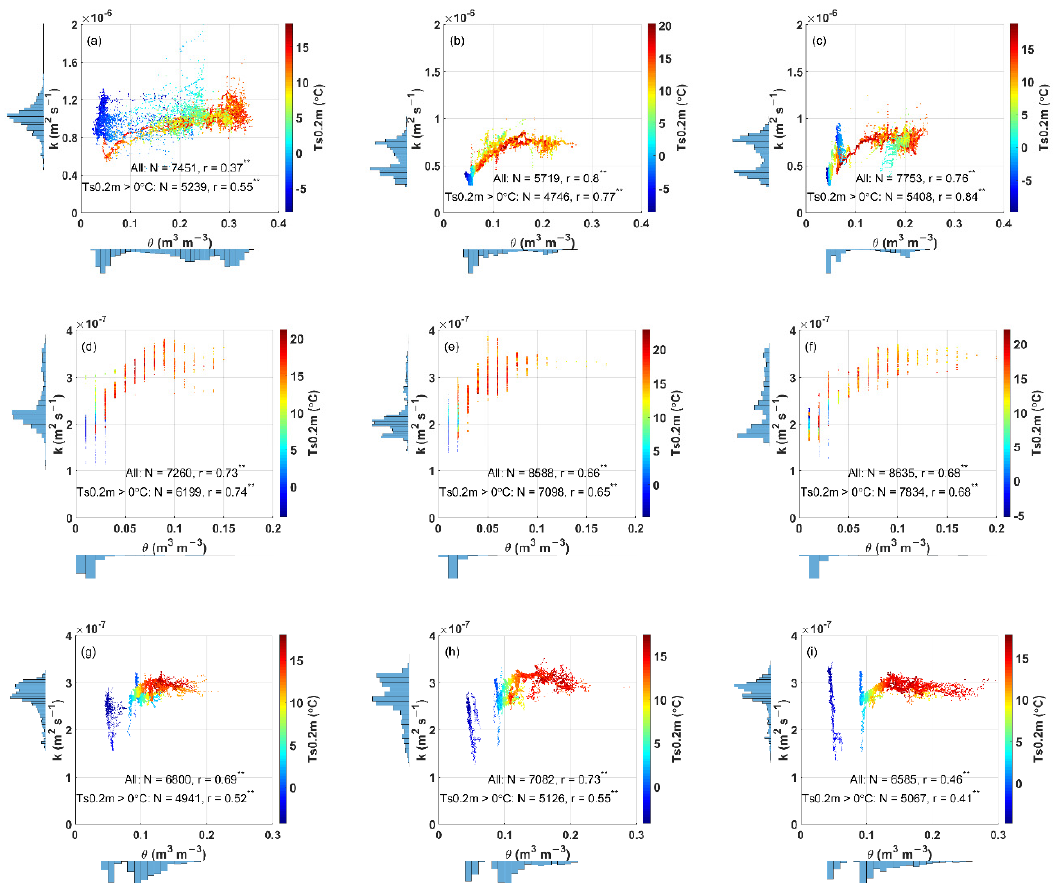
Figure 6. The variation of soil apparent thermal diffusivity (k, m 2 s − 1 ) with soil moisture ( θ , m 3 m − 3 ) at 0.10 m depth on an hourly timescale for 2014 (in the 1st column), 2015 (in the 2nd column) and 2016 (in the 3rd column) at ( a – c ) BJ, ( d – f ) QOMS, and ( g – i ) NADORS, respectively. The color bar indicates the value of soil temperature at the depth of 0.20 m (Ts0.2m), and the larger the temperature, the redder the color. The marker size suggests the amplitude of Ts0.2m (A0.2m), and the larger the value of A0.2m, the larger the marker. The correlation coefficients (r) between k and θ are provided for all of the data and for the data when Ts0.2m > 0 °C, respectively. “**” indicates p -value < 0.01. The probability distributions of k and θ are shown on the y-axis and x-axis sides, respectively.